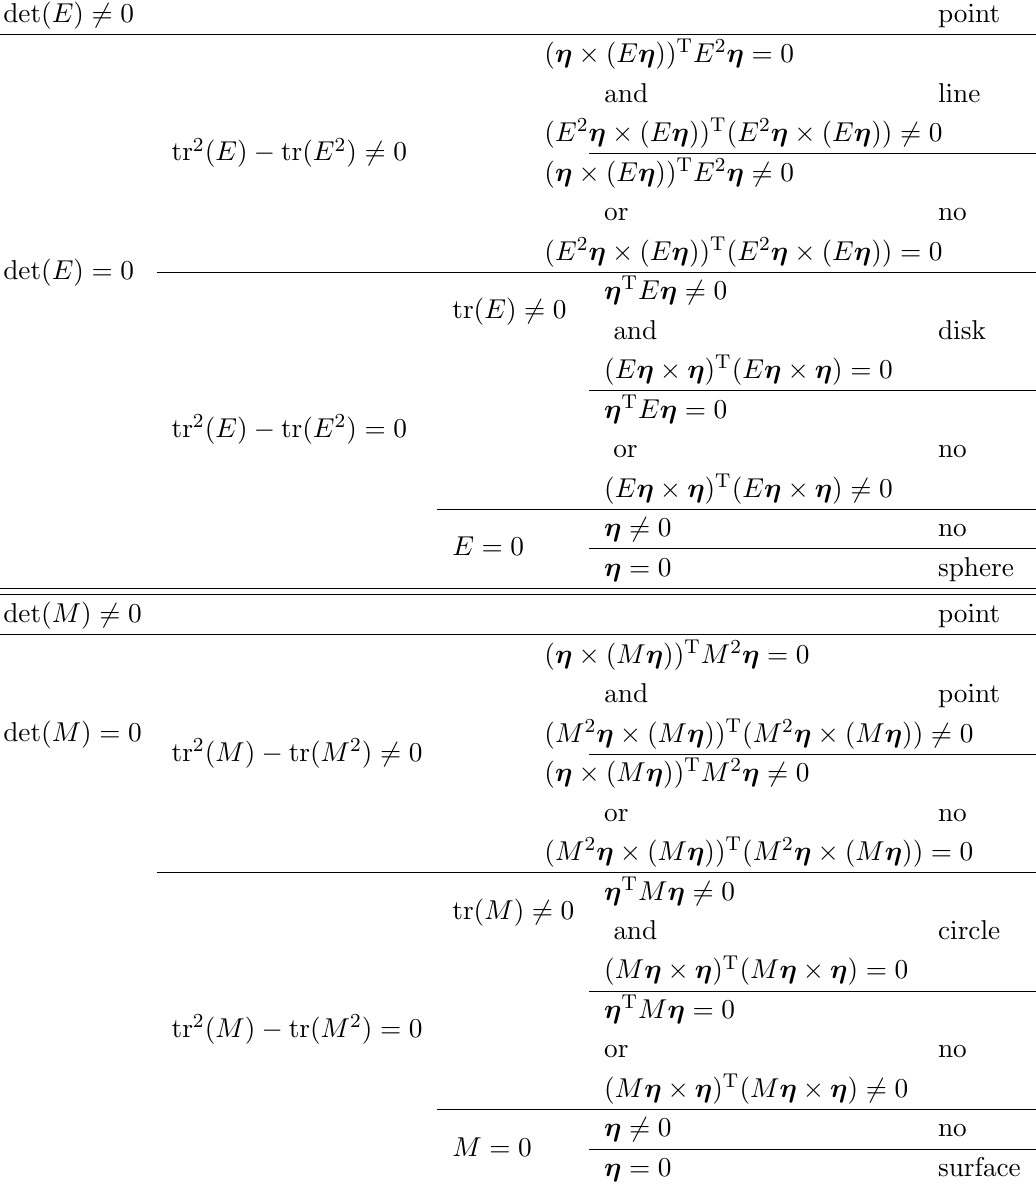
Table 1 . Classi(cid:12)cation of possible realizations of the MPP in the THDM. The last column gives the kind of realization of the MPP or \no" in case the MPP is not realized. The upper part gives solutions for the case j k j < 1 and the lower part for the case j k j = 1. In all cases where the MPP is realizable, the parameter (cid:17) 00 has to ful(cid:12)ll the condition (2.10), respectively, (2.15). The solutions of the vacuum vector h k i follow from (2.9), respectively, the solutions of h k i and u from (2.14). The conditions are given in a basis-invariant way and are therefore directly applicable to any